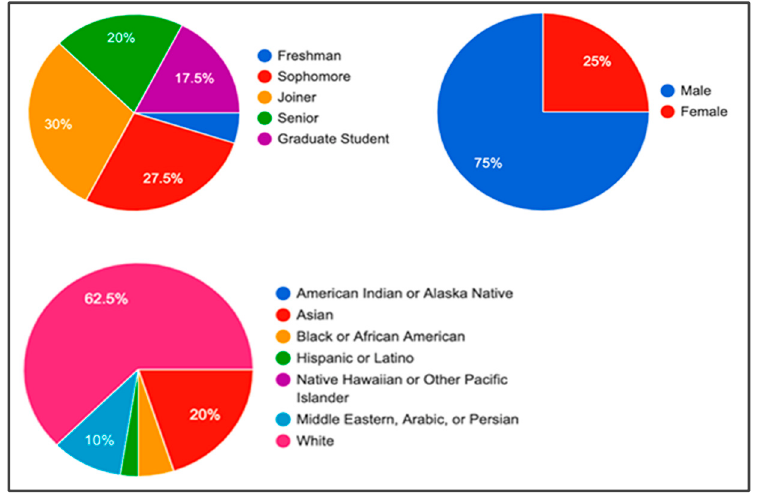
Figure 12. The demographic data of the participants.